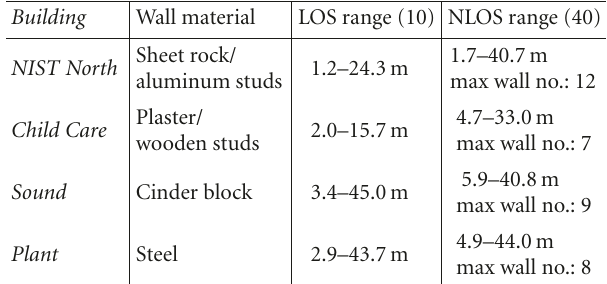
Table 2: Experiments conducted in measurement campaign.